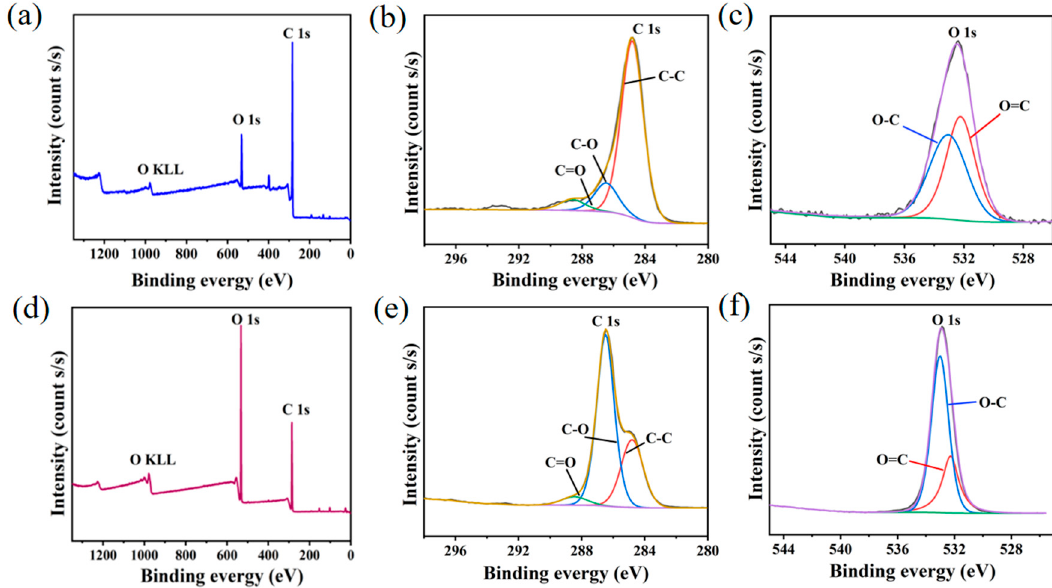
Figure 5. High-resolution XPS spectra of YC ( a – c ) and YC/D-mannitol ss-PCM ( d – f